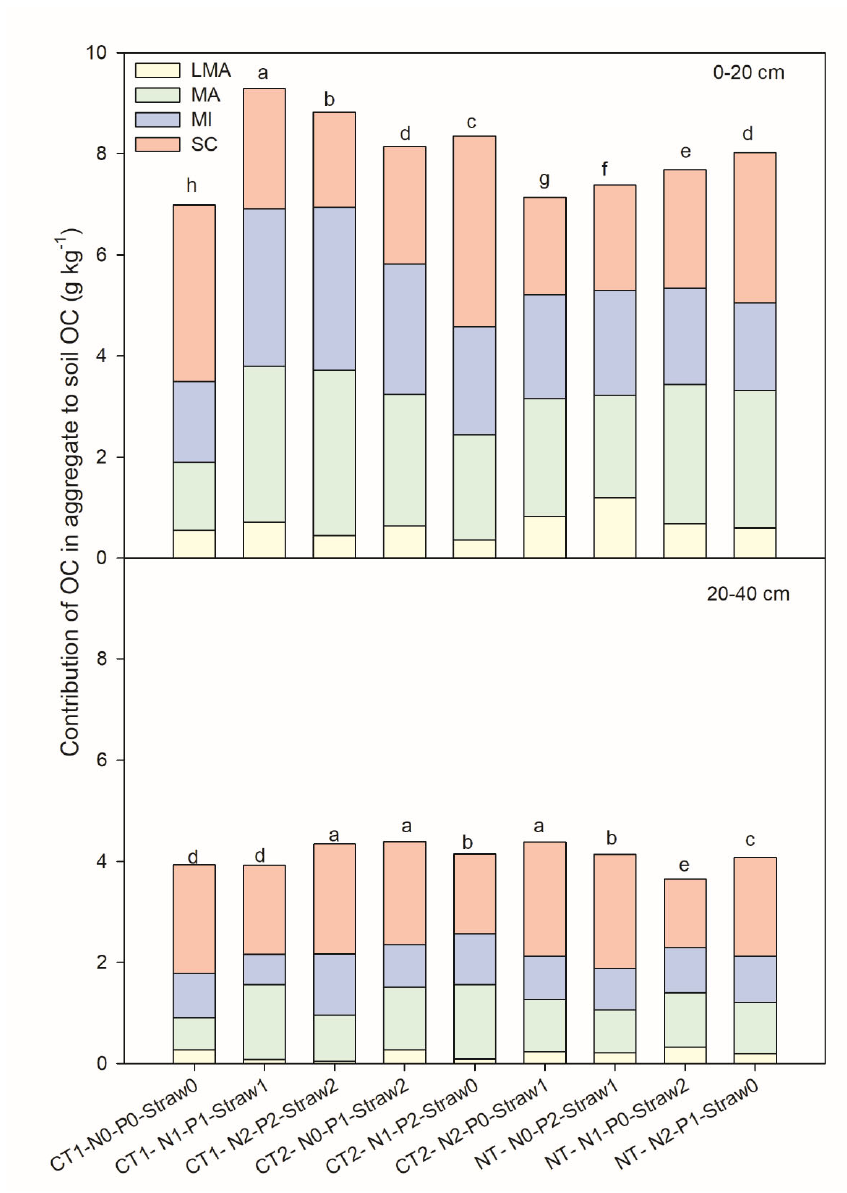
Figure 2. Soil organic carbon (OC) content (g kg –1 soil) in four aggregate size fractions (>2,